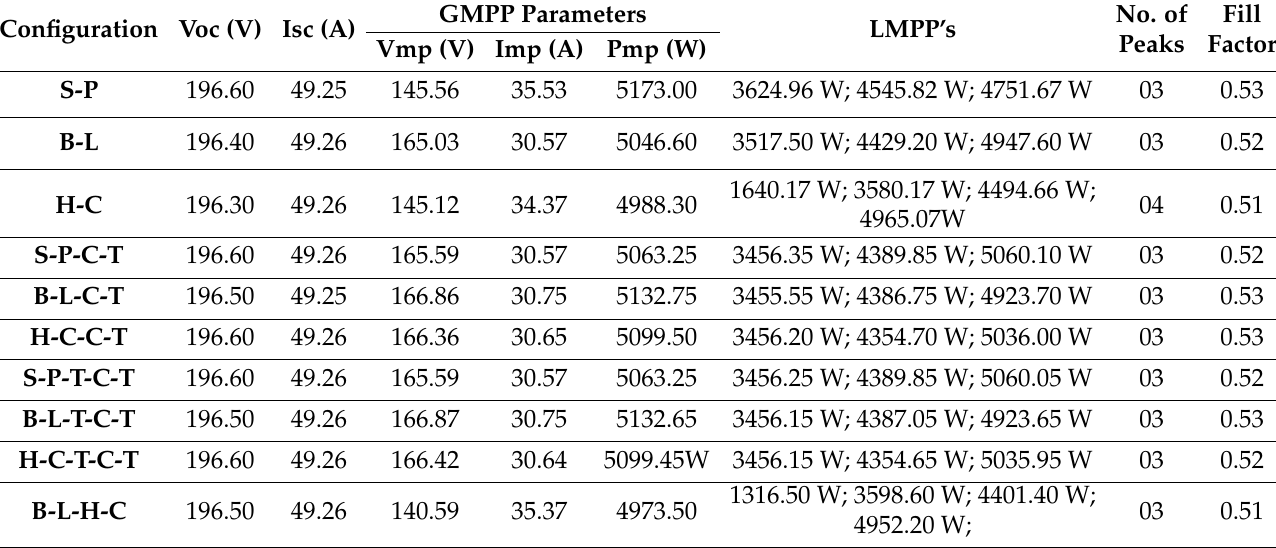
Table 5. Parameter variations of conventional and hybrid array configurations under SAN pattern.